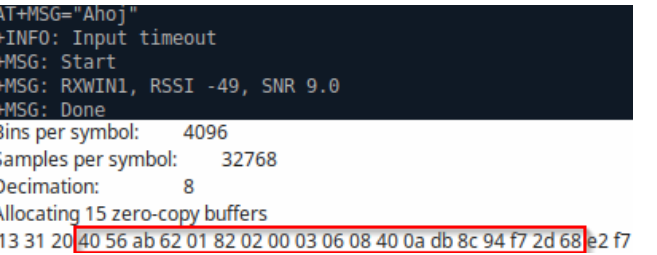
Figure 13. Packet sent from the victim ED (top, black background) and the packet captured by GNU Radio (bottom, white background).